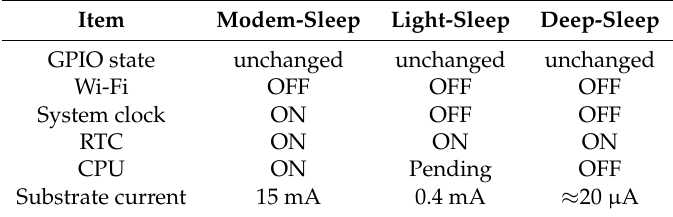
Table 1. Summary of the ESP8266EX’s low-power